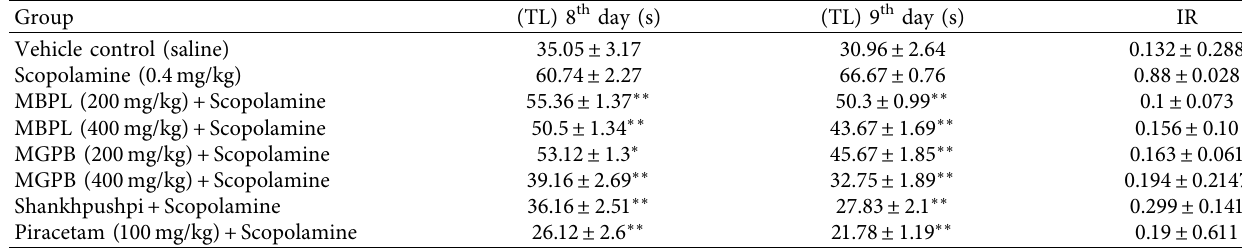
Table 2: Memory-enhancing activity of plant extract.